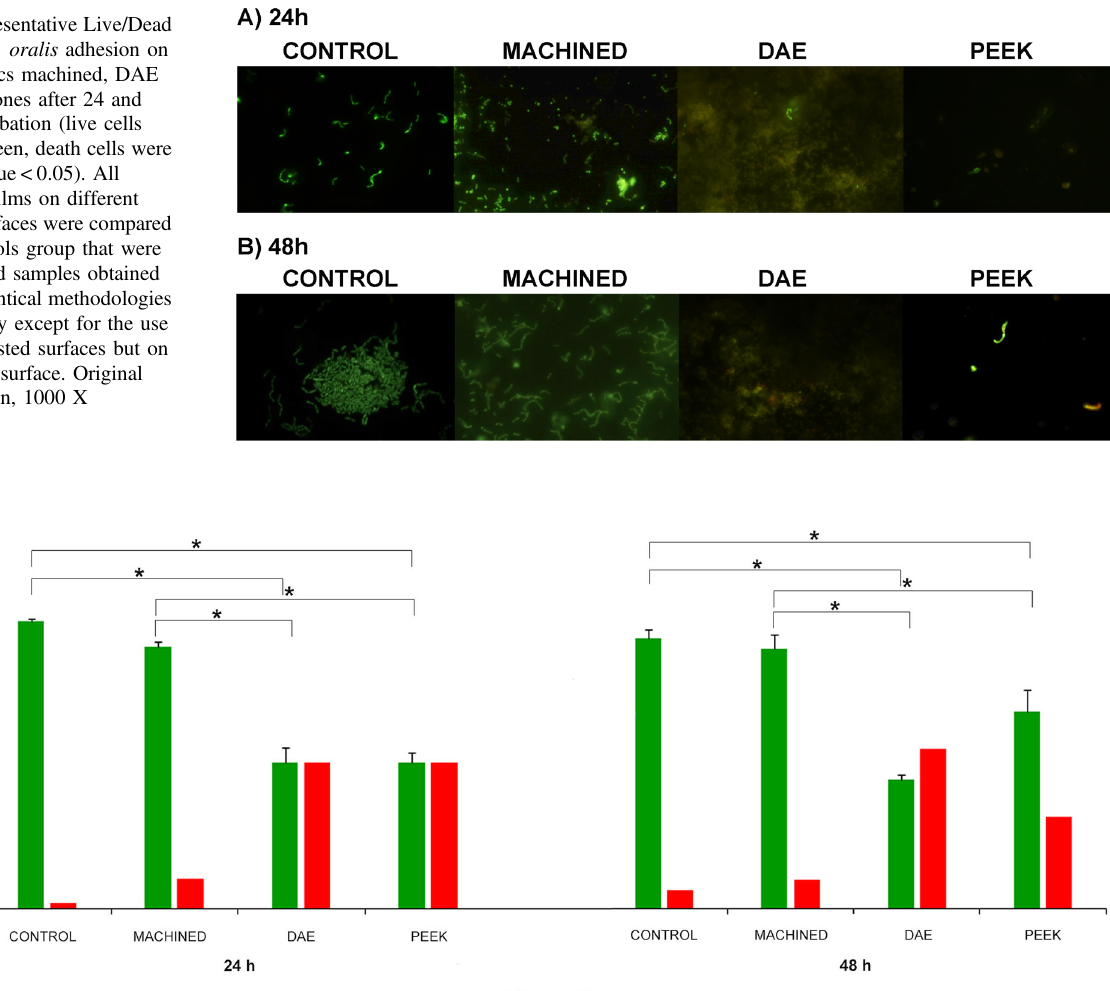
identical methodologies in every way except for the use of one of tested surfaces but on polystyrene surface. The control group was used to evaluate the effect of the each treatment(* p -value <